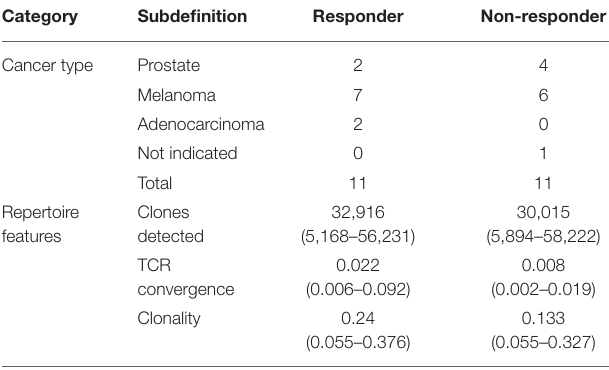
TABLE 1 | Cancer type and summary repertoire features for 22 individuals receiving CTLA-4